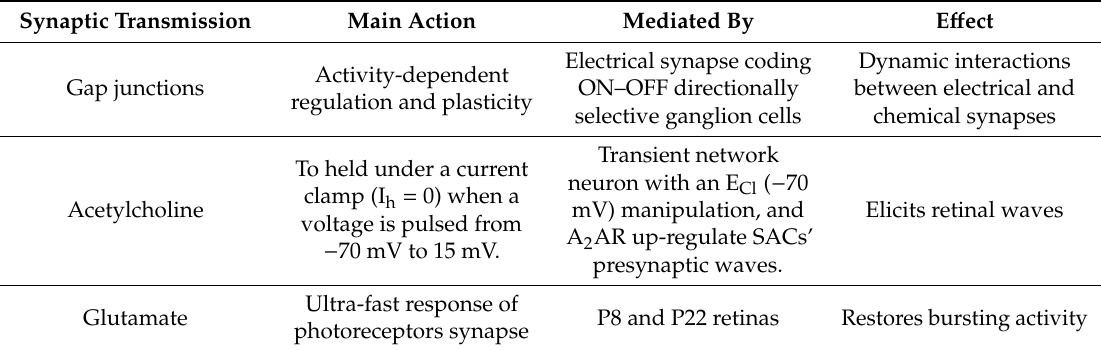
Table 1. Impact of the junctions and synaptic transmission on retinal networking. Synaptic